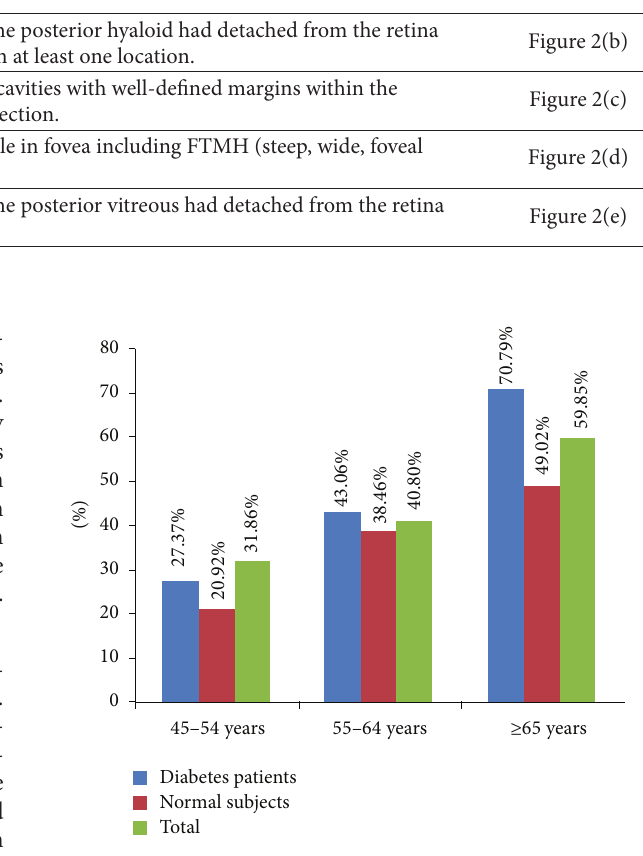
Figure 1: The prevalence of vitreoretinal interface abnormalities in different age